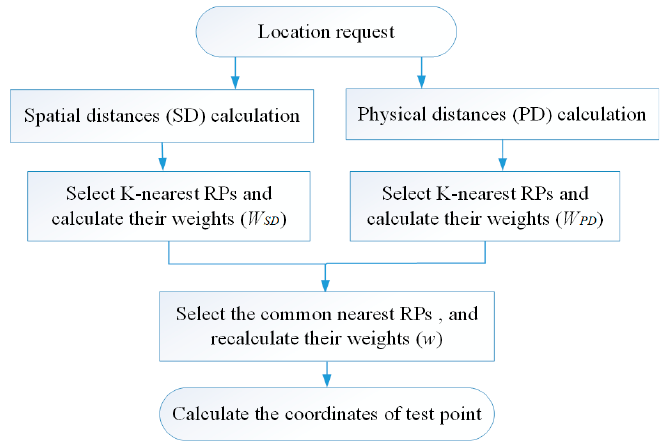
Figure 1. The framework of the proposed algorithm.